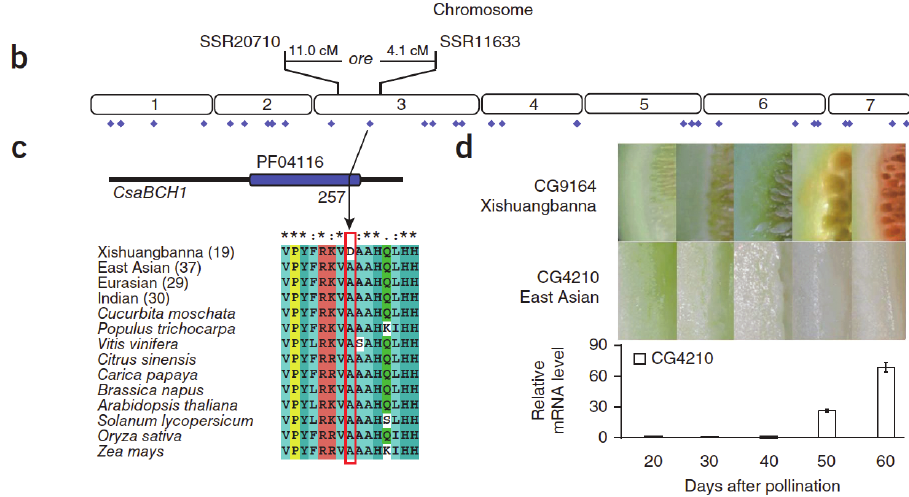
Figure 3. Physical position of the ore gene on Cucumis sativus chromosome 3. Blue diamonds below the seven chromosomes indicate the positions of 43 SNPs c Mutation at residue 257 changing the conserved amino acid of a putative β -carotene hydroxylase ( CsaBCH1 ). Xishuangbanna group cucumbers carry asparagine, whereas all other cucumbers and homologous proteins from ten other species carry alanine d CsaBCH1 mRNA levels in Xishuangbanna cucumbers that accumulate β -carotene. Reproduced from Qi et al.